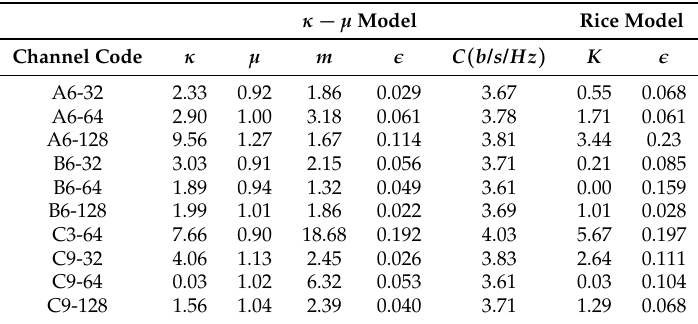
Table 3. Fitting parameters of the κ − µ distribution and the Rice distribution for the measured channels.